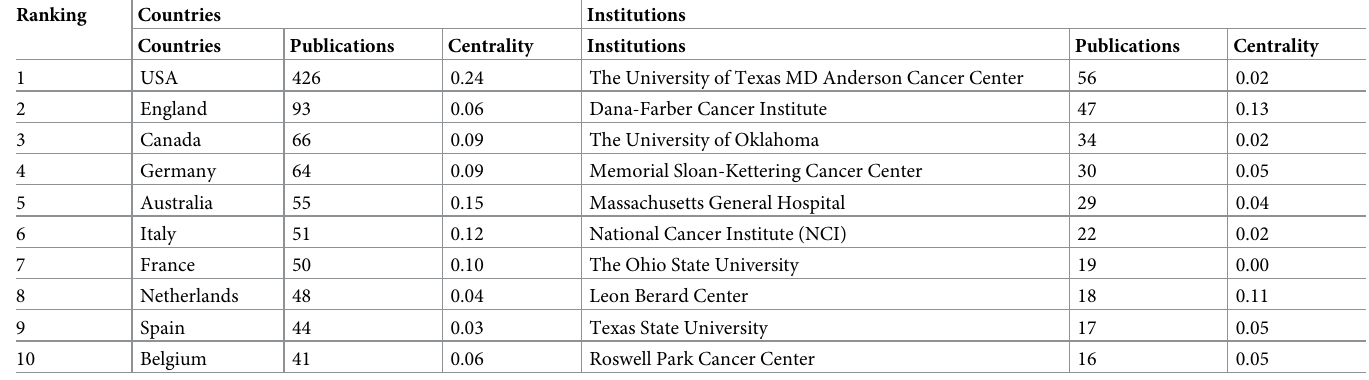
Table 1. Top 10 research countries and